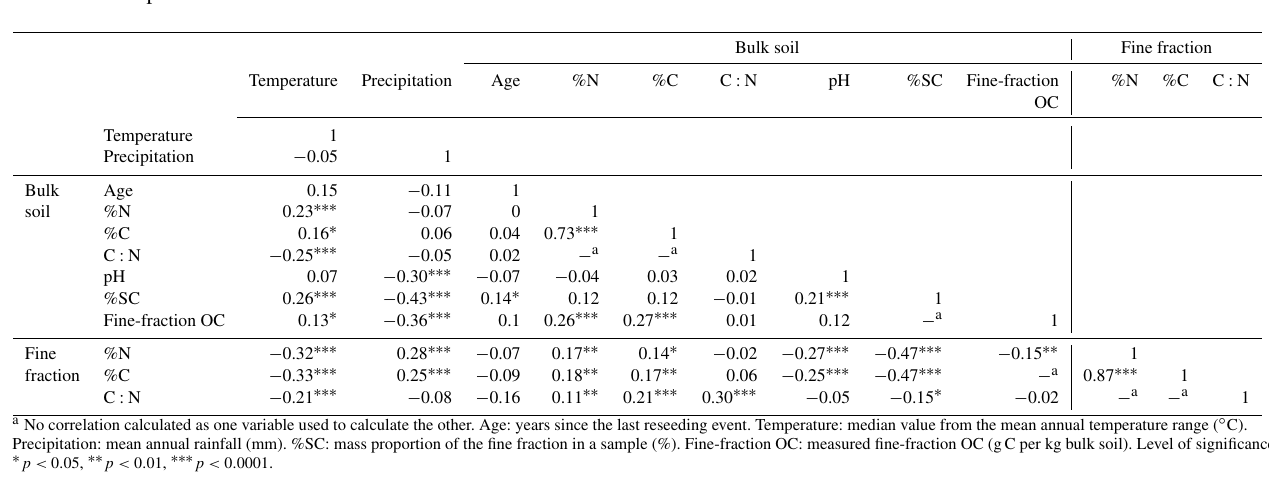
Table 2. Correlation matrix of Kendall’s tau ( τ ) coefficients for bulk and fine-fraction ( < 20µm) soil properties, sward age and known environmental parameters.